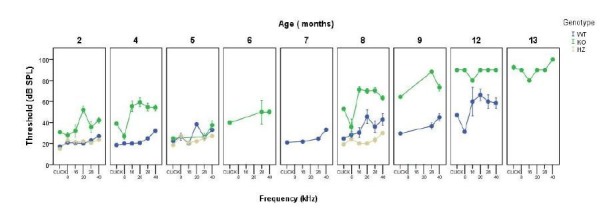
Monthly evolution of auditory thresholds.